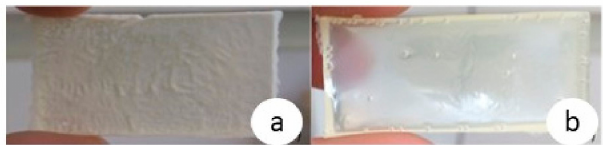
Figure 3. Photograph of the 100-0 PHBHV-L TetraSH networks ( a ) and 70–30 PHBHV-L TetraSH co-networks ( b ).